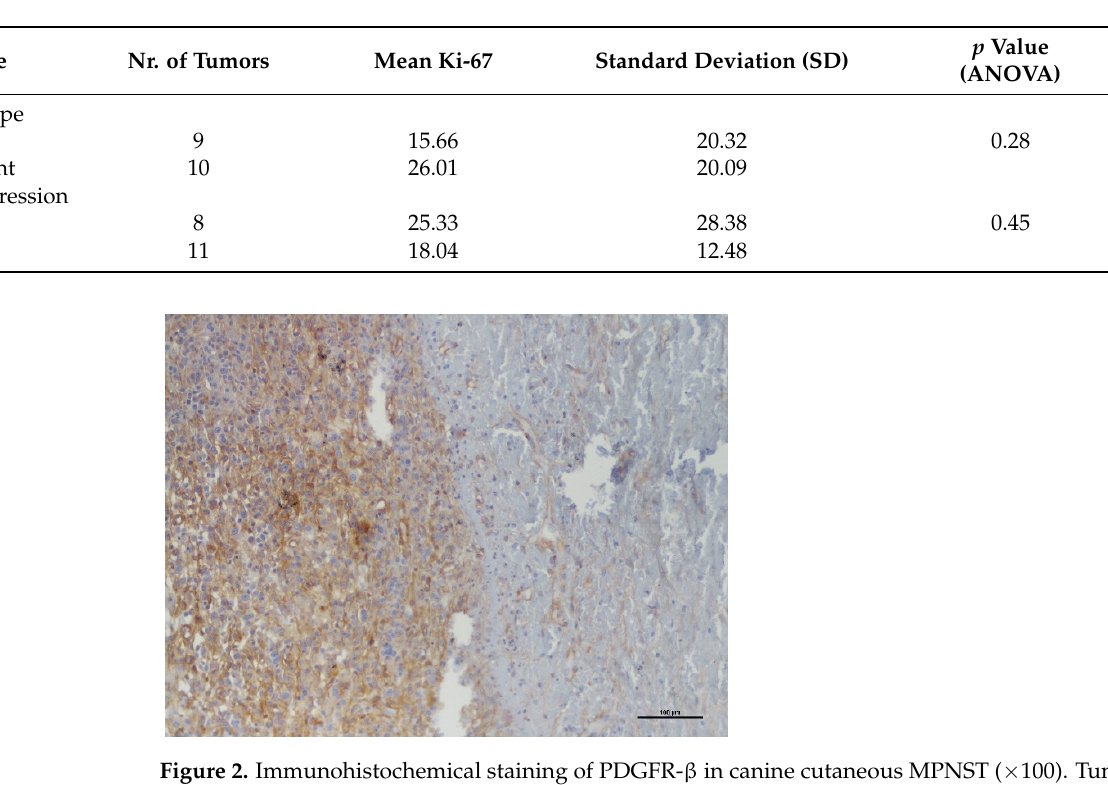
Table 3. Relationship between the mean Ki-67 expression, tumor type and PDGFR- β expression in canine PNST.